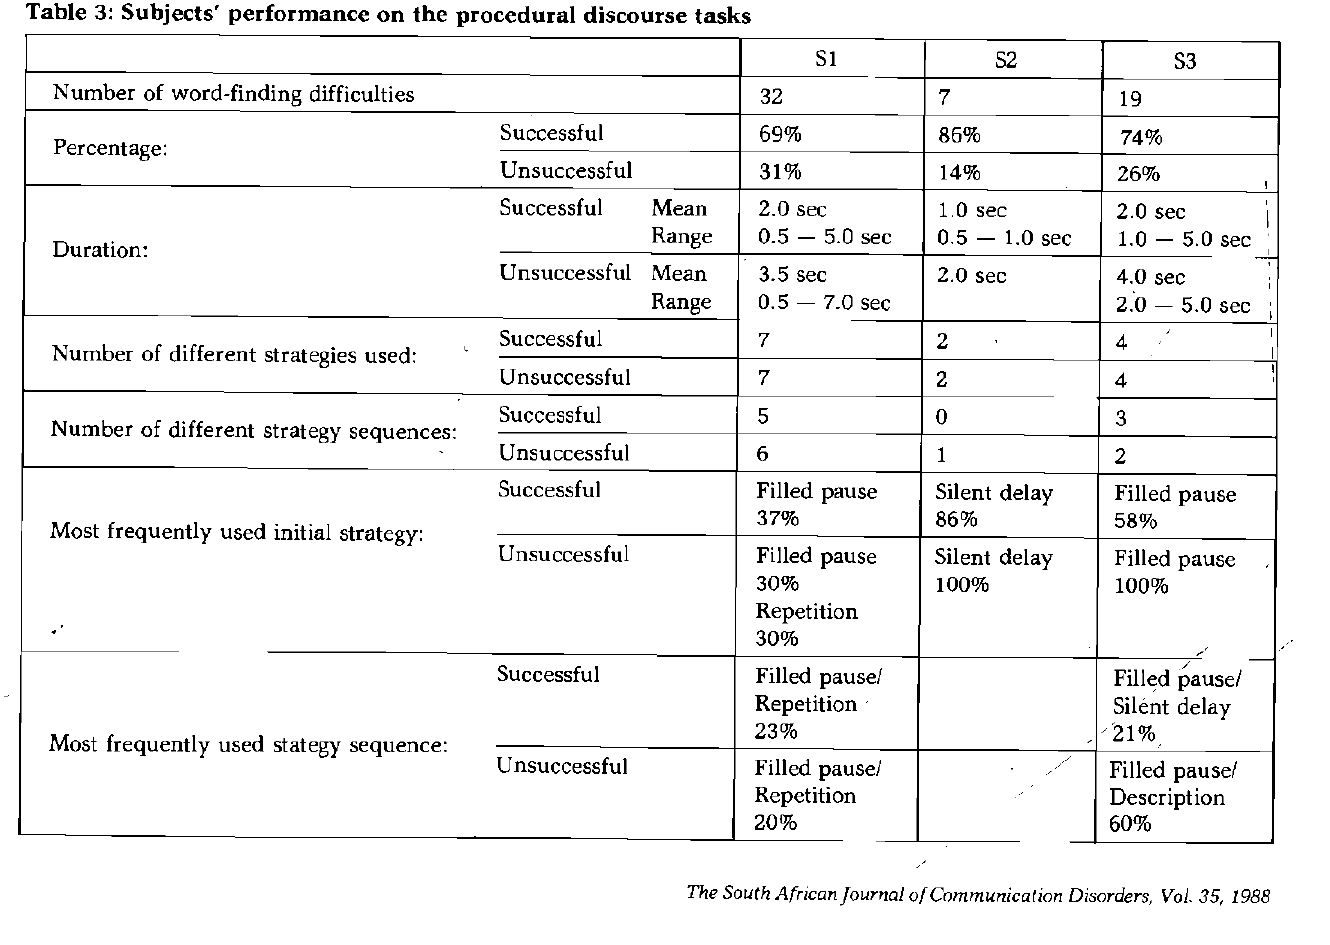
Table 3: Subjects' performance on the procedural discourse tasks Number of word-finding